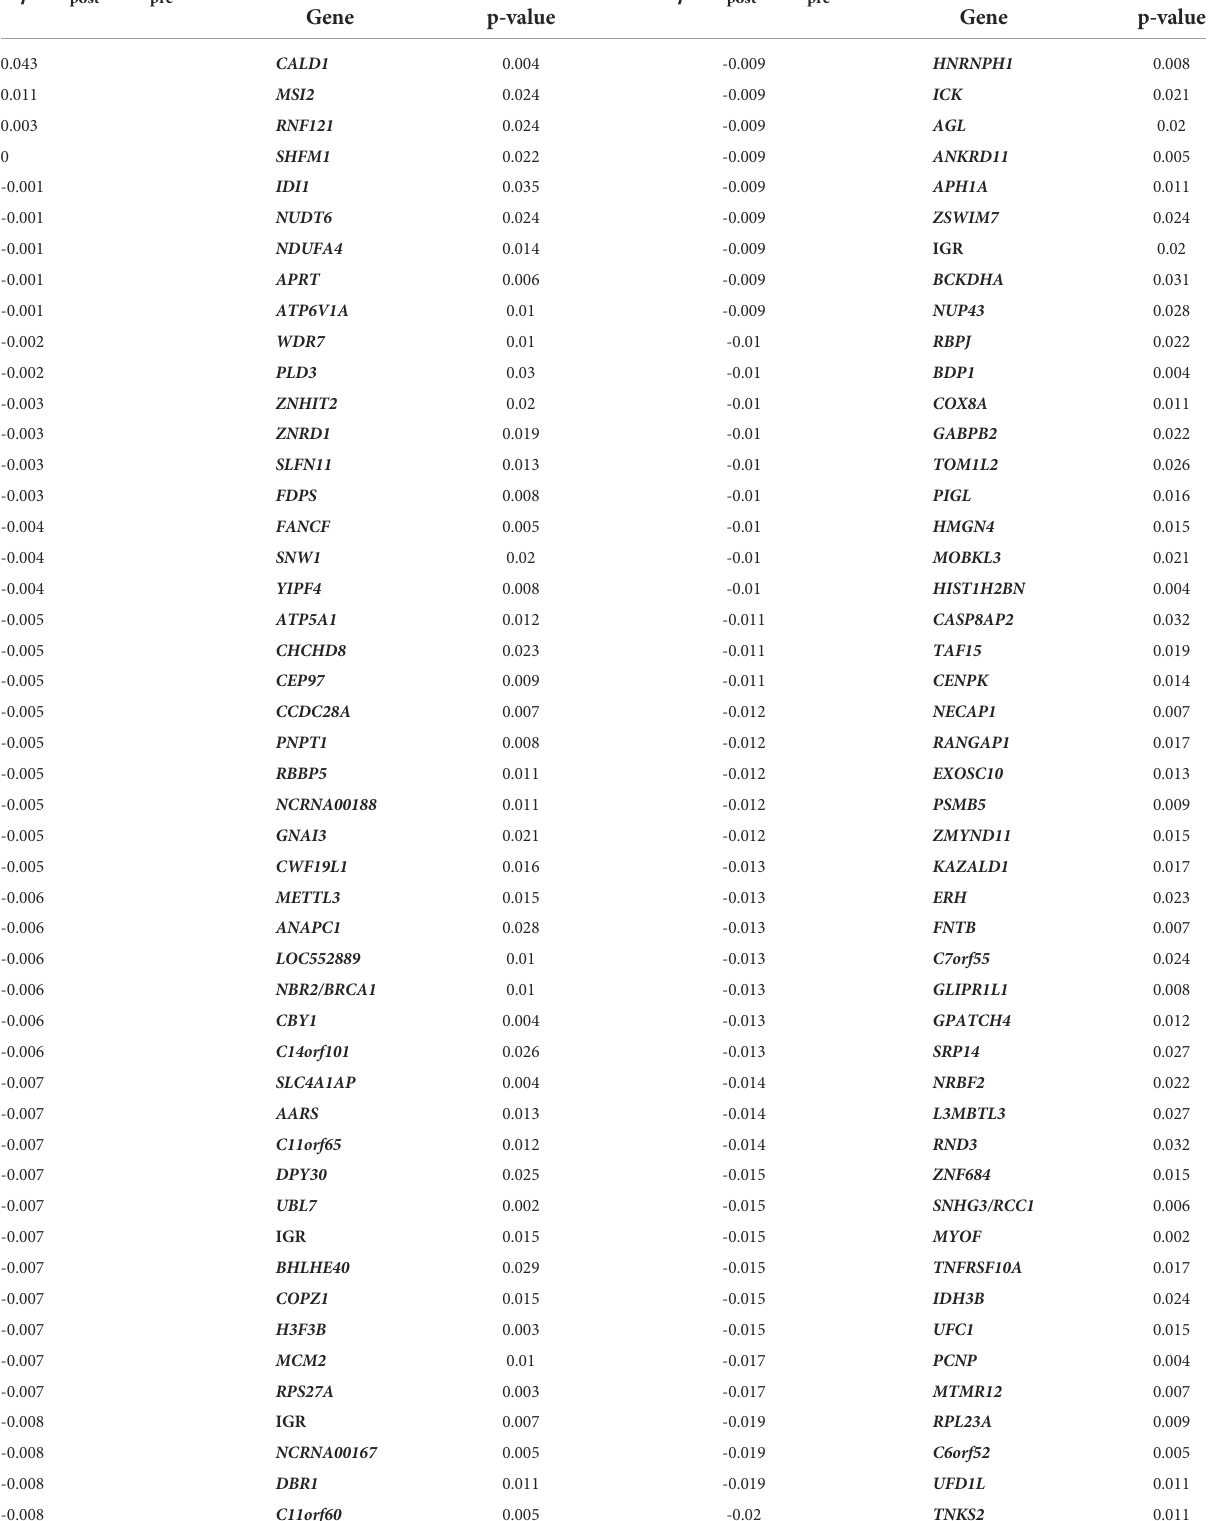
TABLE 6 Differentially Methylated Regions (DMRs) from the PG post compared to the PG pre after 14-week physical intervention